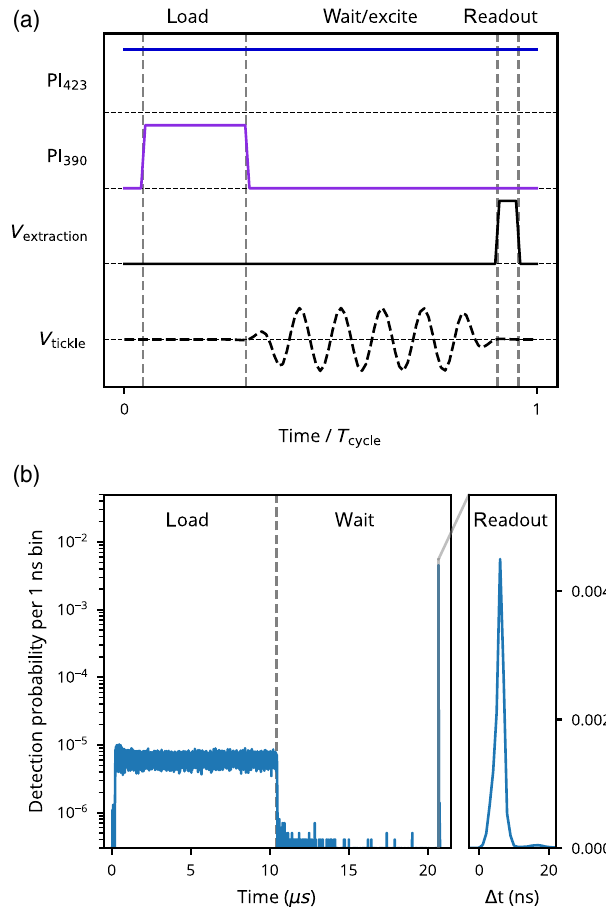
FIG. 4. Measurement protocol and typical data. (a) Illustration of one cycle of the experimental protocol. Free electrons are created during the loading phase when the 390-nm laser is switched on. A rf tone is applied to one dc electrode in some experiments during the “ wait/excite ” phase. Voltage pulses to three dc electrodes in the “ readout ” phase eject electrons in the direction of the mesh and MCP. (b) Histogram of MCP detection events for experiment with load and wait times t 10 μ s. During loading, some untrapped electrons are accelerated into the MCP, replicating the 390-nm laser pulse shape. The extraction pulse empties the trap into the MCP, resulting in a large and sharply localized signal. Inset: close-up of the histogram during the readout The inset displays a close-up of the readout signal, which peaks with a full width at half maximum of about 2 ns. Note that the inset uses a linear scale for the readout signal, while the full cycle is displayed using a semilogarithmic scale to show the background during loading as well.